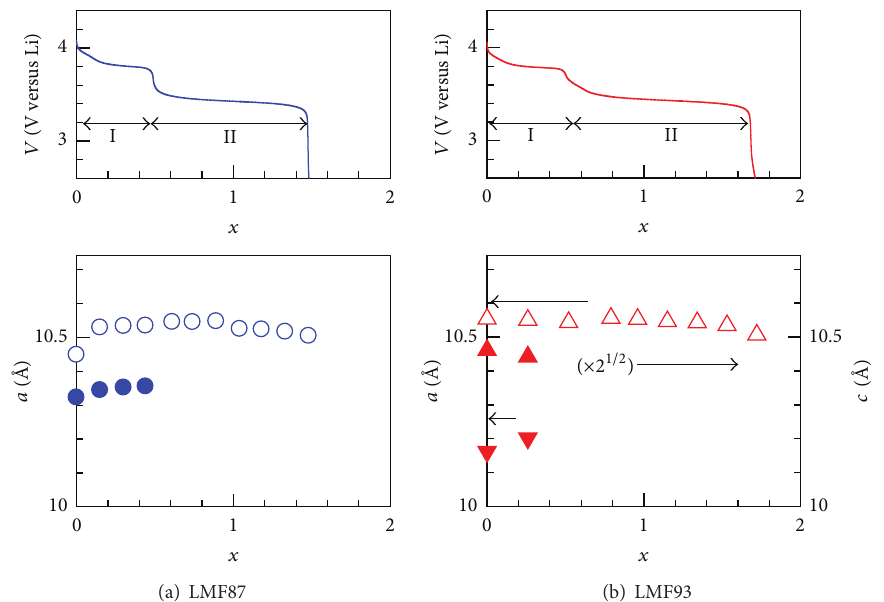
Figure 8: Discharge curve and lattice constant (a) of (a) LMF87 and (b) LMF93 against 𝑥 . Filled marks represent the second tetragonal phase (cited from [18]).